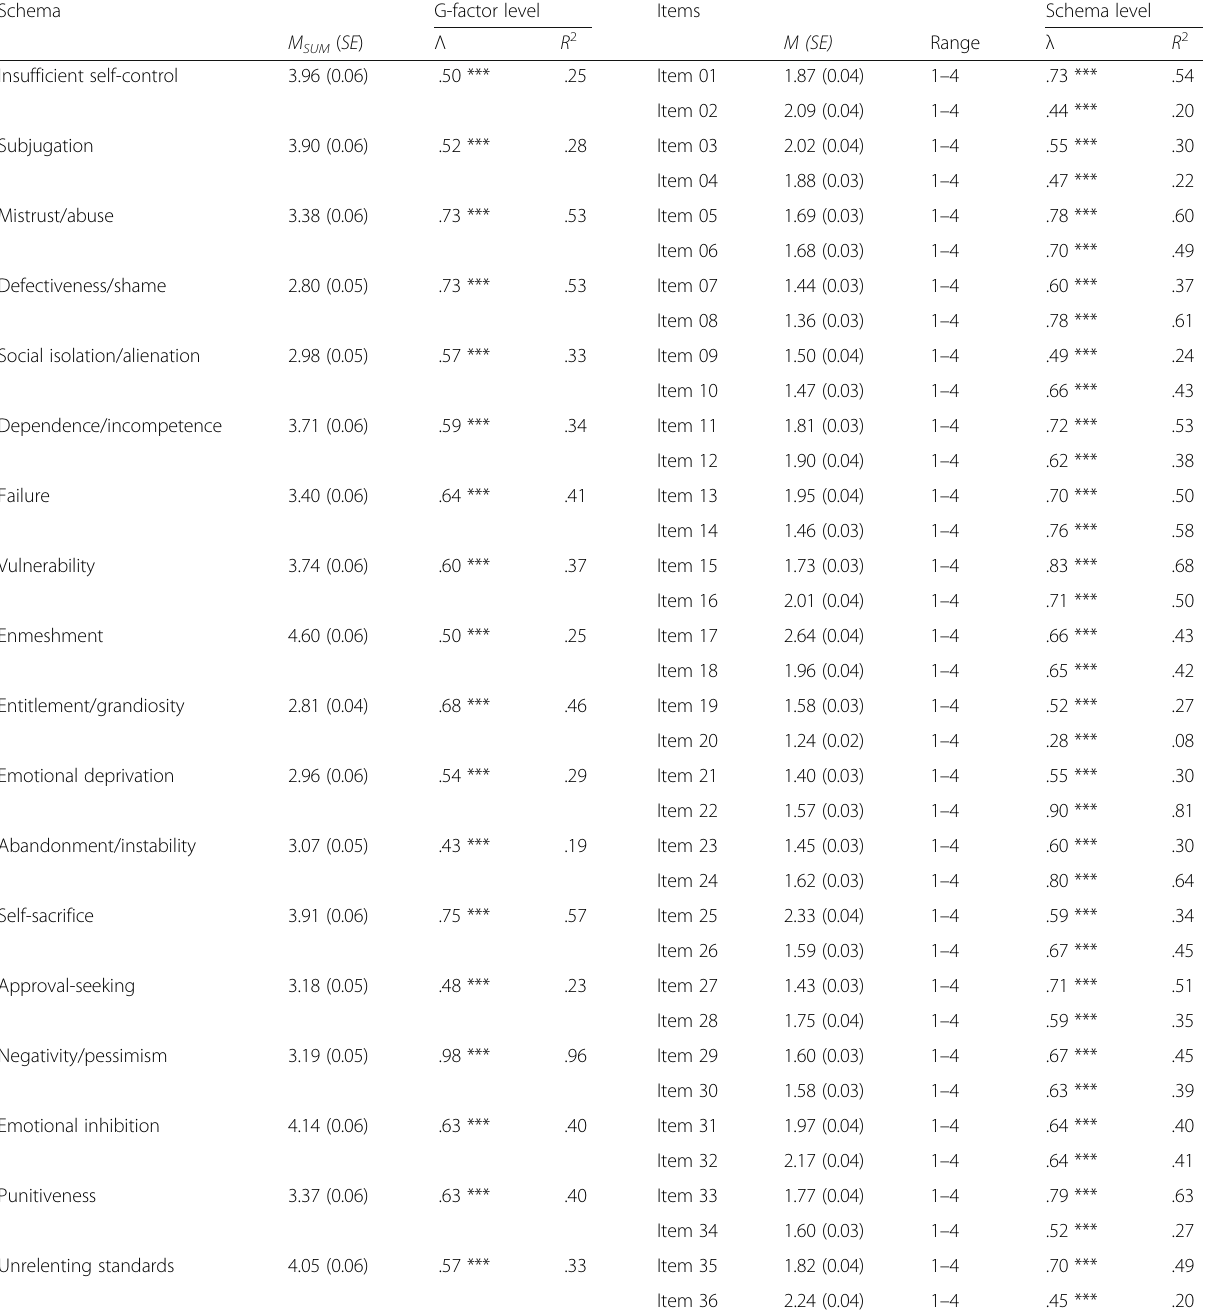
Table 3 Parameters within the model: descriptive statistics, standardized regression weights ( λ ), squared multiple correlations ( R 2 ) from the CFA on schema and item